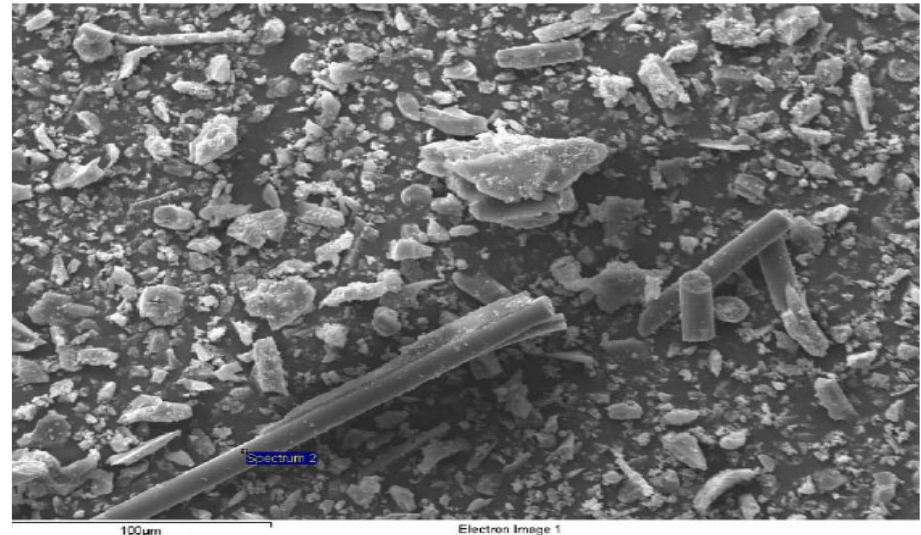
Figure 4. Scan Electronic Microscopy of Plastic Waste: Used as per Elsevier Permission [25].